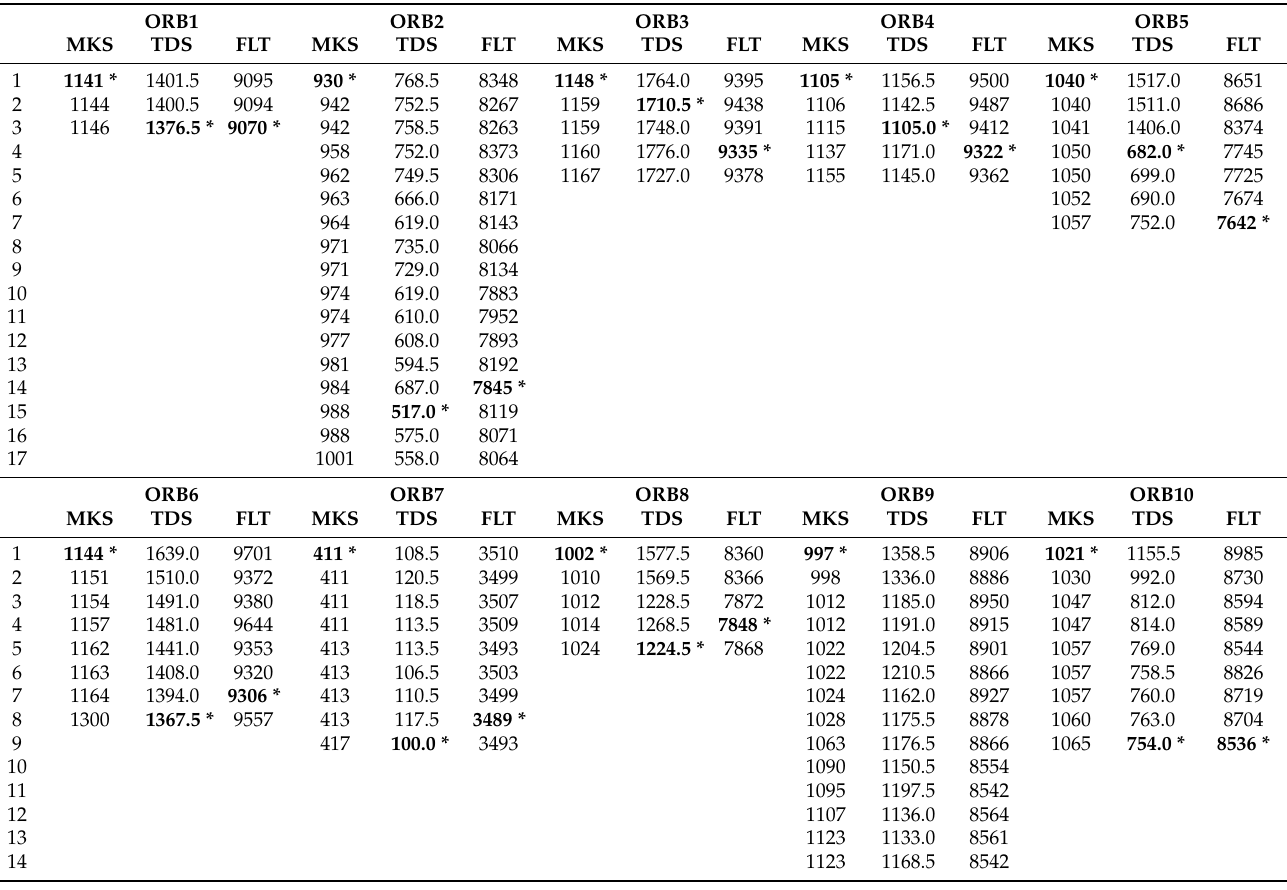
Table A2. Non-dominated solutions obtained by SS/LS for the JSSP instances proposed by